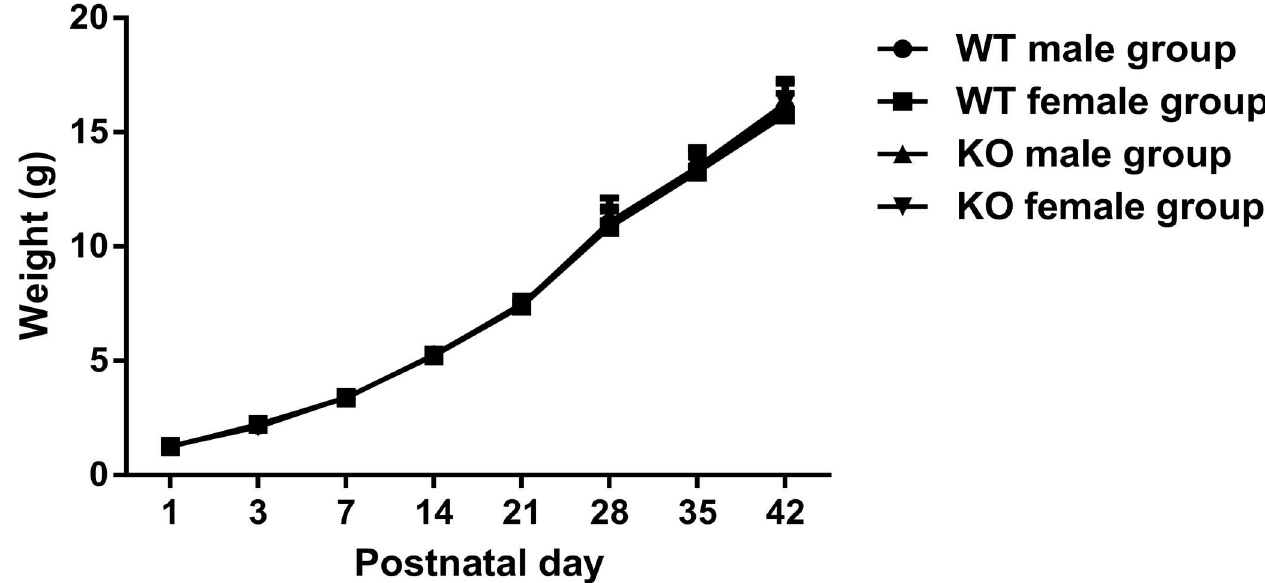
Fig 1. Comparative growth curves. Line chart showingthe weight gain of the control and model groupsfrom postnatalday 1 to postnatal day